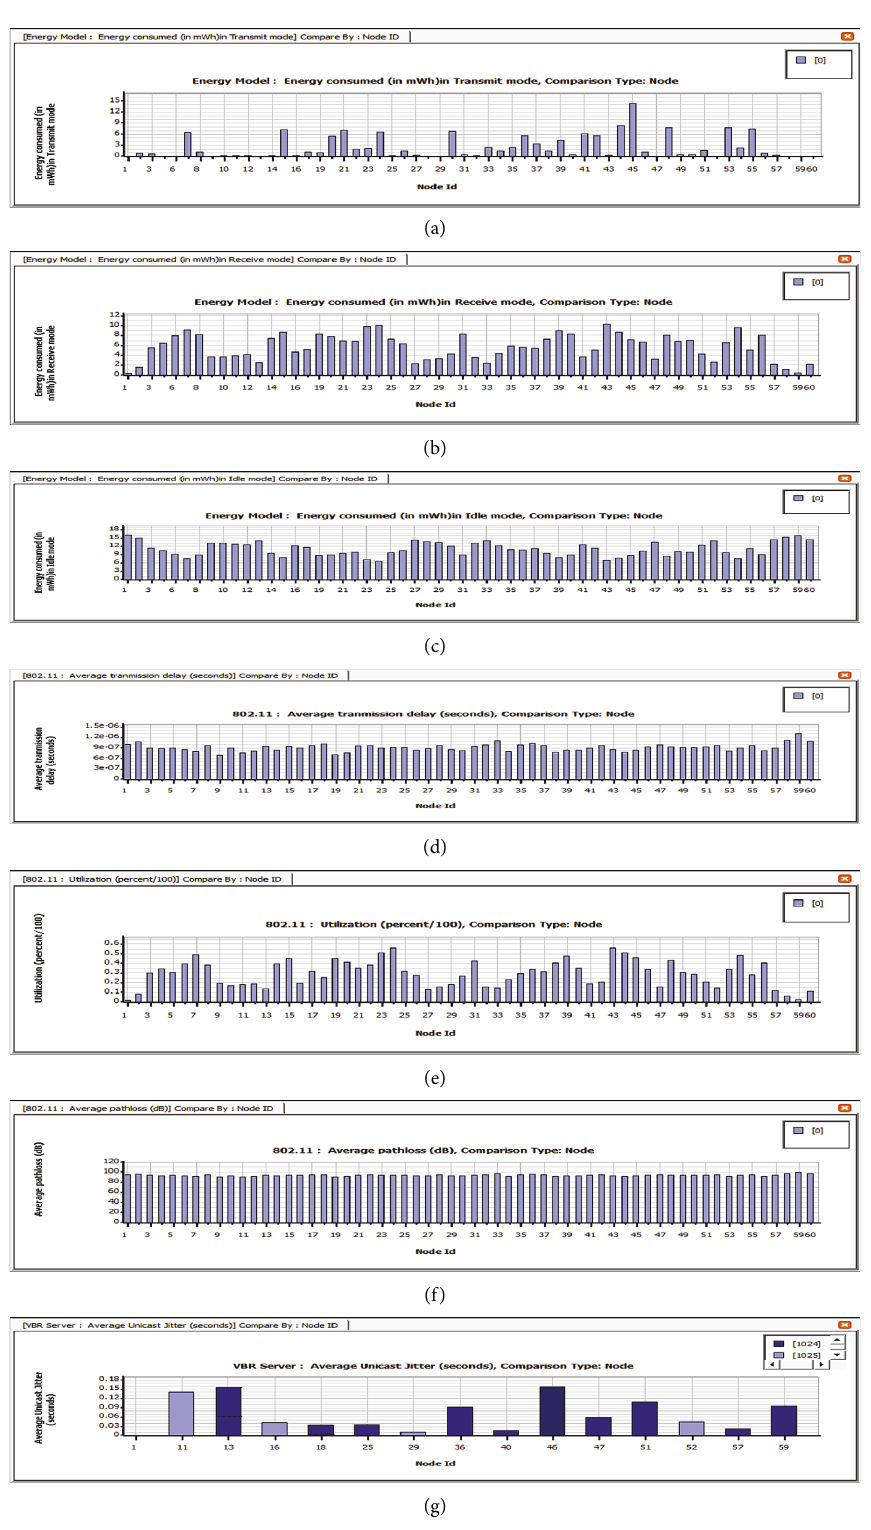
Figure 19: (a) Transmit mode energy consumption of DSR for VBR deployment. (b) Receive mode energy consumption of DSR for VBR deployment. (c) Idle mode energy cnsumption of DSR for VBR deployment. (d) Average transmission delay of DSR for VBR deployment. (e) Percentage of utilization of DSR for VBR deployment. (f) Average pathloss of DSR for VBR deployment. (g) Average jitter of DSR for VBR